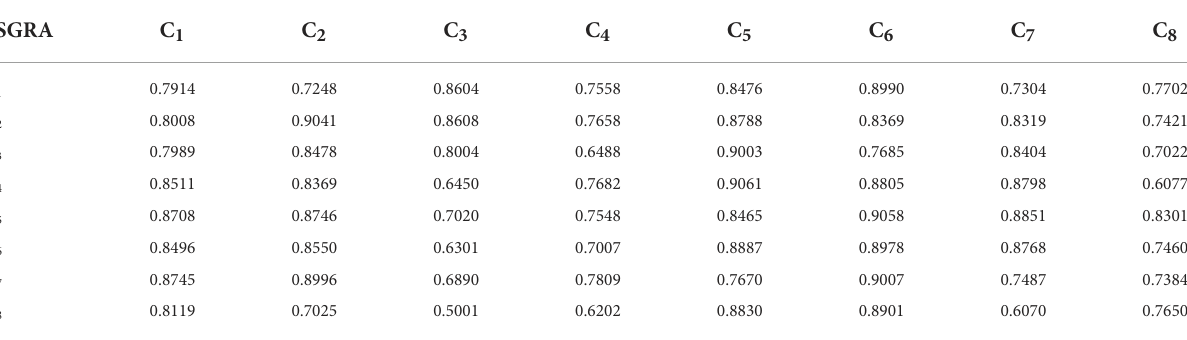
TABLE 3 Criteria action